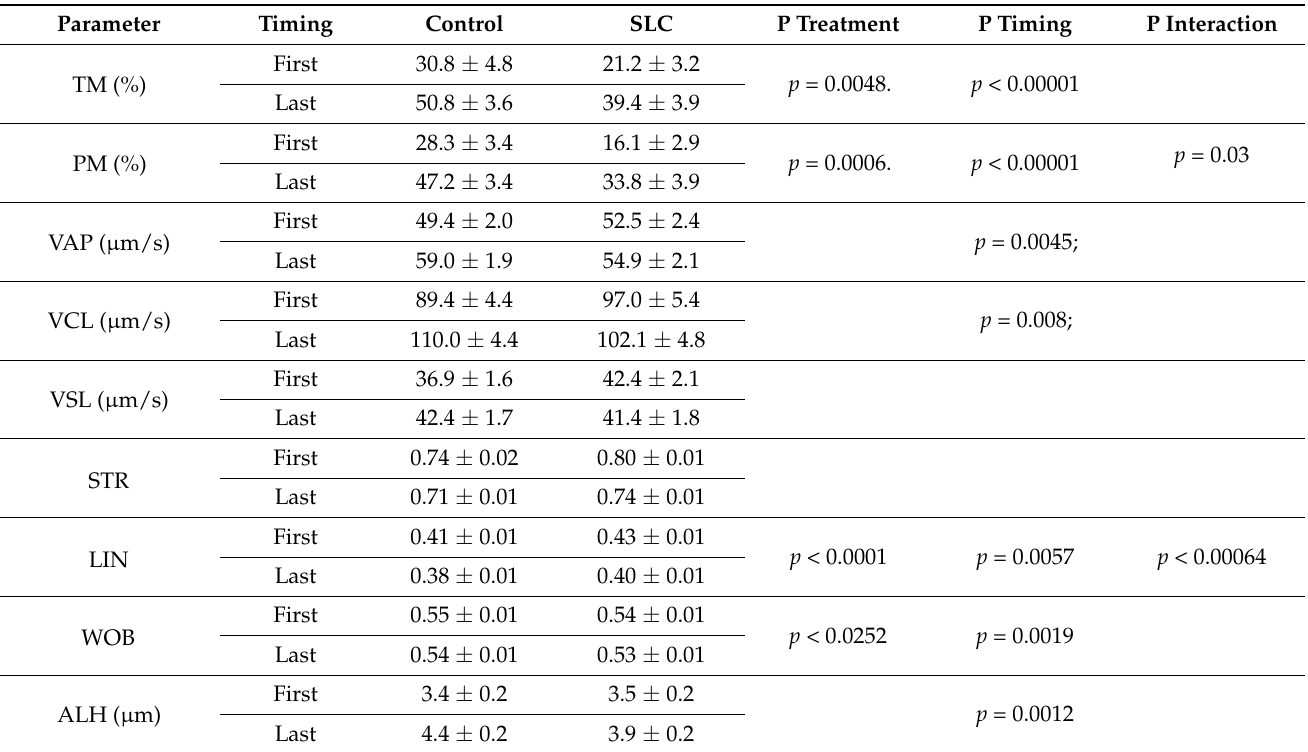
Table 5. Sperm kinematics for control and single-layer centrifugation samples in first and last ejaculates (n =